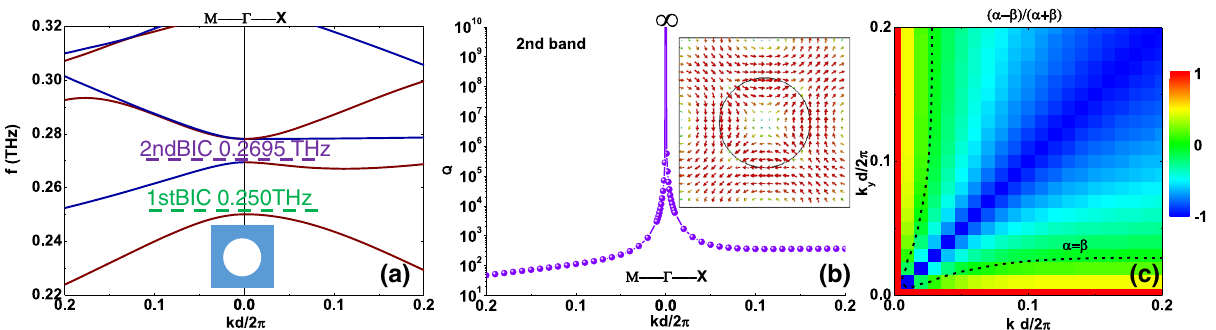
Fig. 2 Symmetry-protected BIC in a photonic crystal slab. a Band structure of the silicon photonic crystal slab. The inset shows the schematic view of the unit cell of the designed photonic crystal slab. Red (blue) color denotes the guide mode that can ef fi ciently couple to the incident TE (TM) polarization. b Q -factor of the 2nd band along the symmetry direction. The inset illustrates the eigenmode ( E fi eld) at z = 0. c Radiation coupling difference ð α (cid:3) β Þ = ð α þ β Þ as a function of the wave vectors close to the 2nd BIC. The dashed line shows the critical coupling condition α ¼